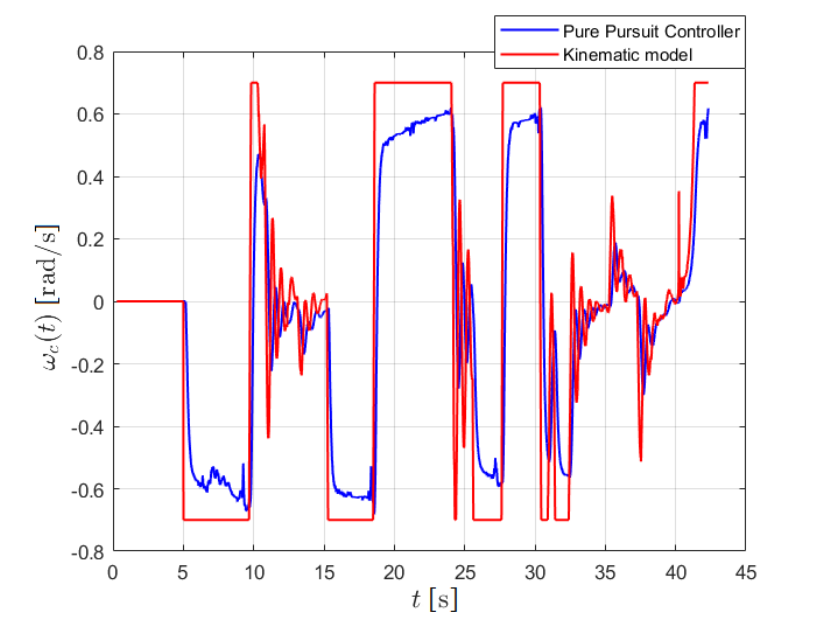
Figure 20. Angular velocity ω c ( t ) of the QBot 2e